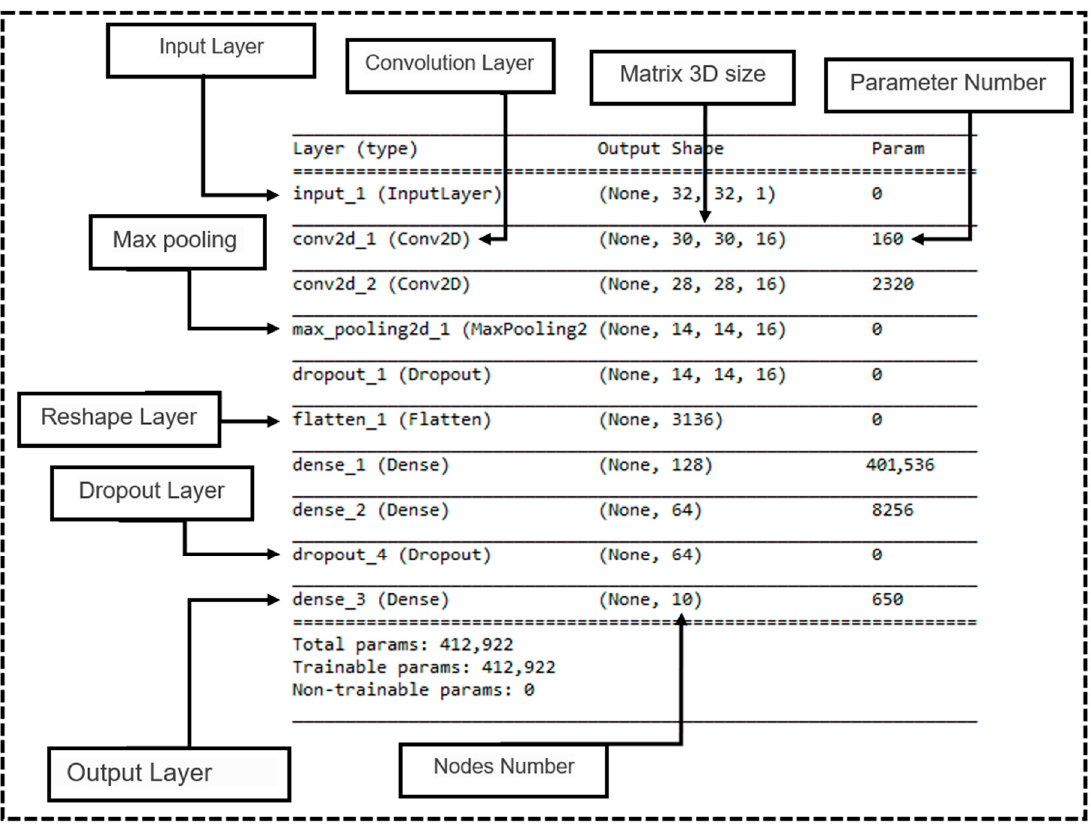
Figure 2. A summary of the proposed CNN configuration that uses the Mol2Mat